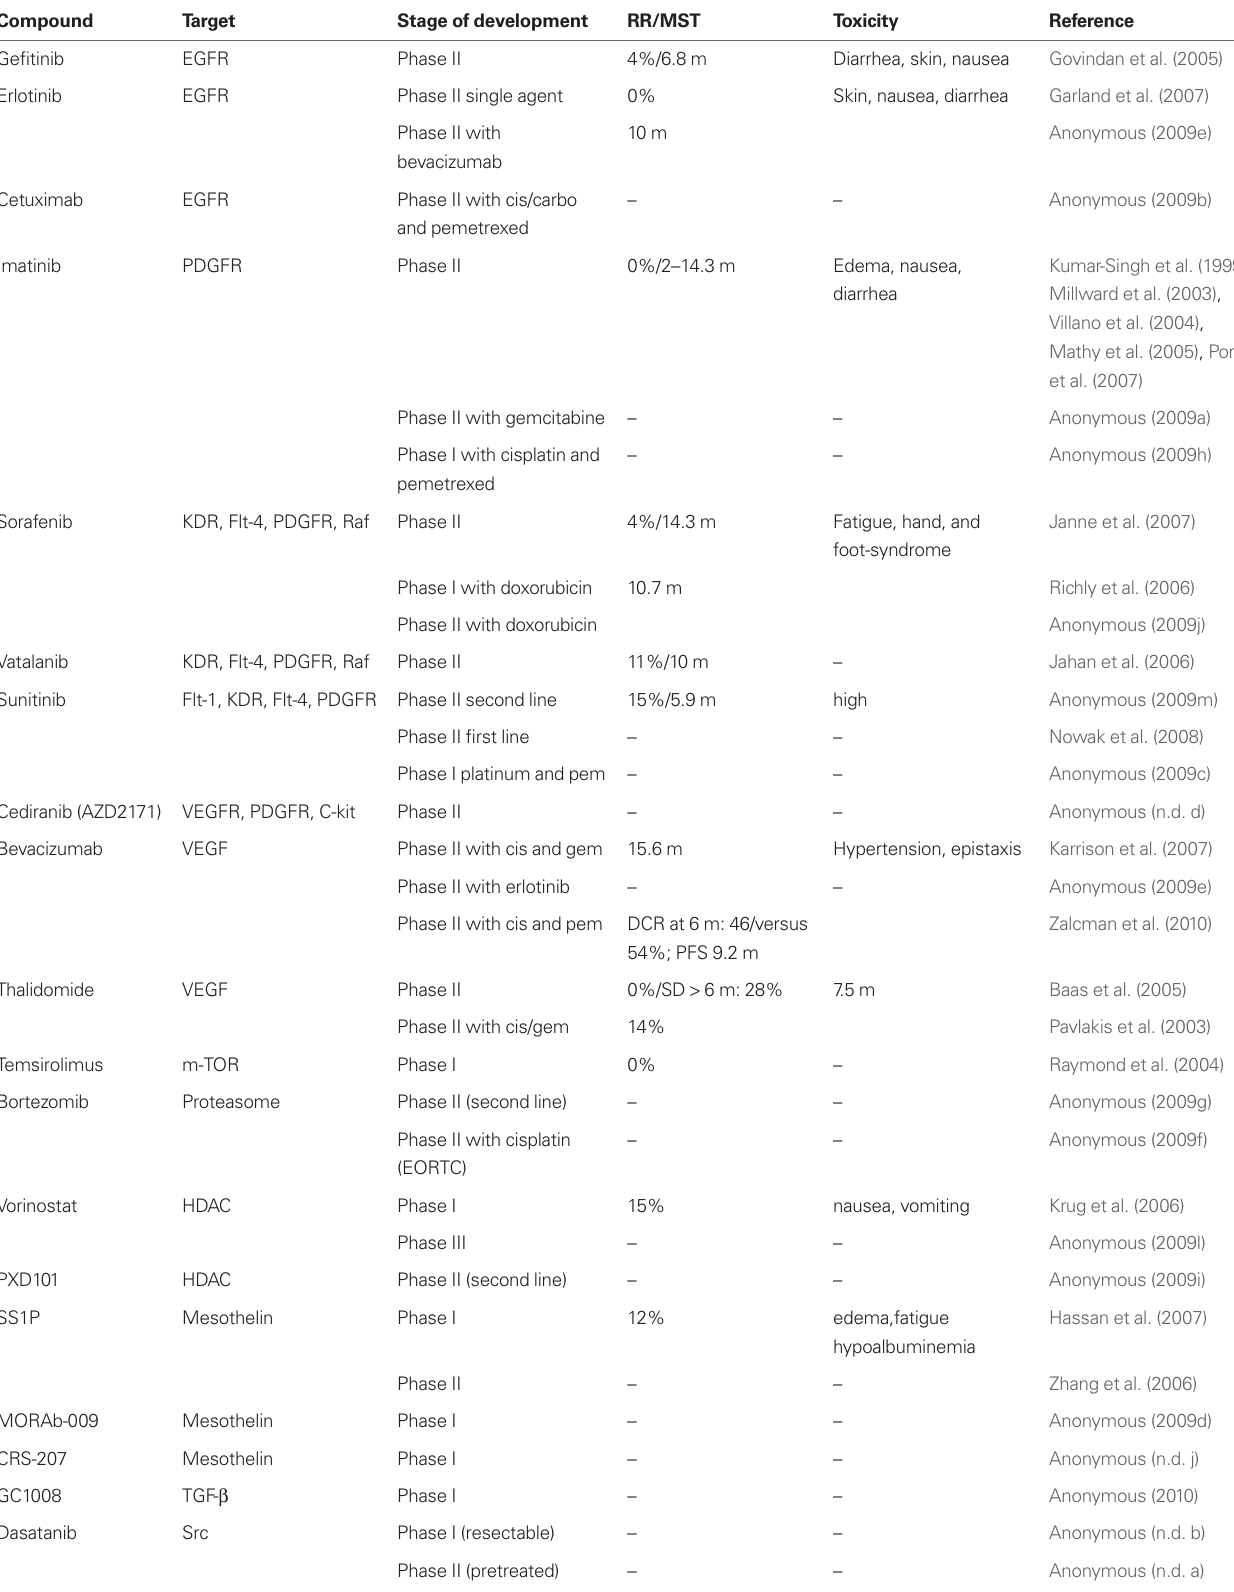
Table 2 | Targeted agents in